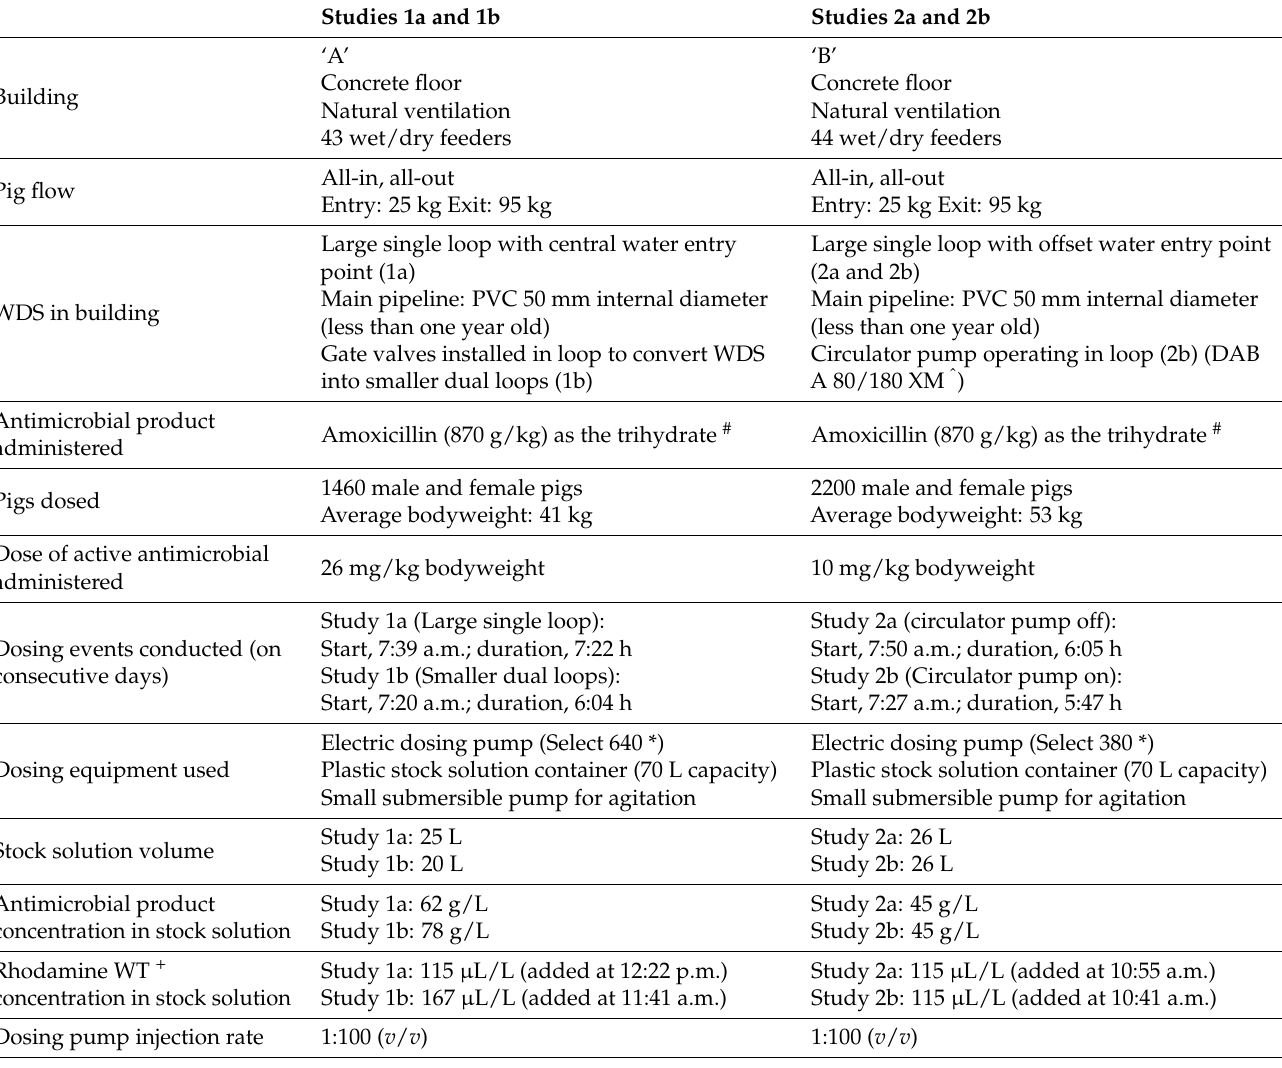
Table 1. Descriptions of Studies 1a, 1b, 2a and